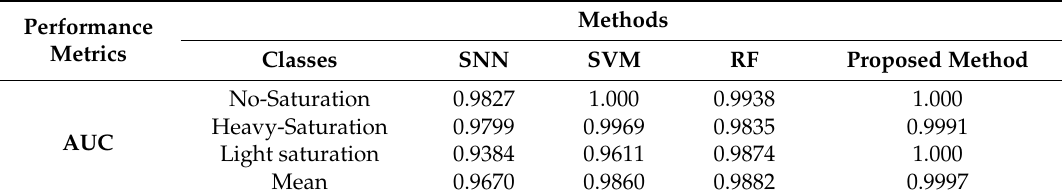
Table 14. Performance comparison of the different methods using ROC-AUC curve.